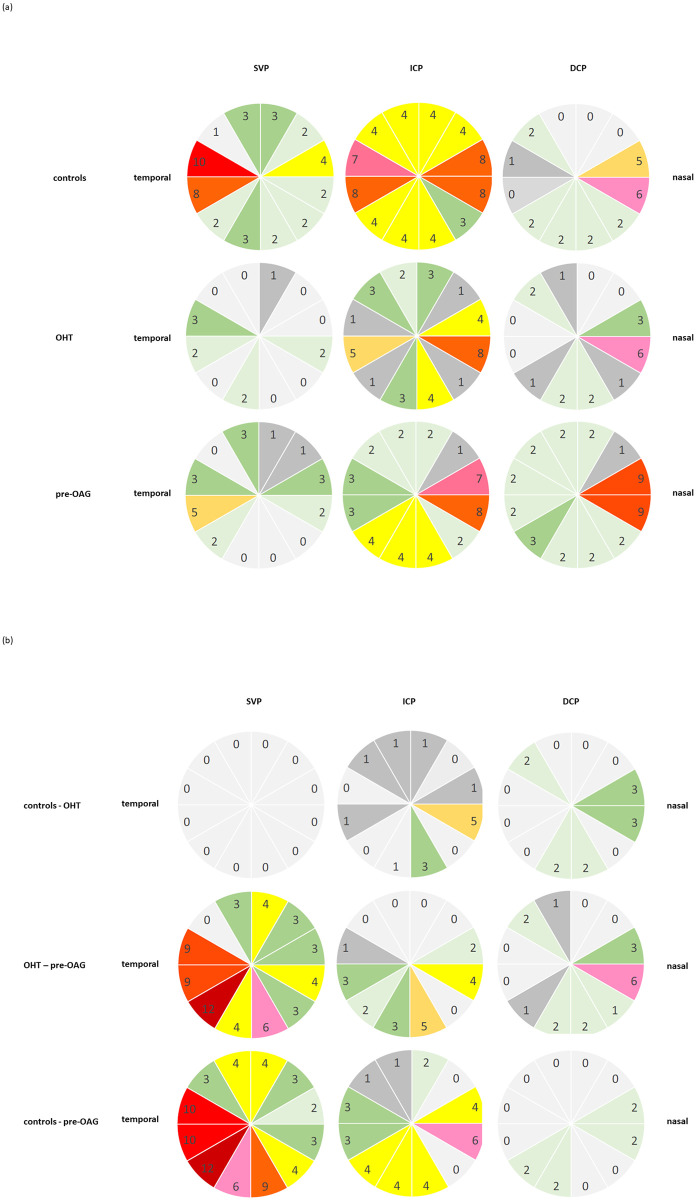
Qualitative analysis of the number of significant interactions between vessel density of each sector (s1-s12) of macula OCT-A in SVP, ICP, and DCP by color coding (red, n = 8–12; pink, n = 6–7; orange, n = 5; yellow, n = 4; green, n = 2–3; grey, n = 0–1) in controls, OHT, and pre-OAG eyes, respectively (a) and between the groups (b) with age correction of the data: Notice the temporal emphasis in SVP and the nasal emphasis in DCP.